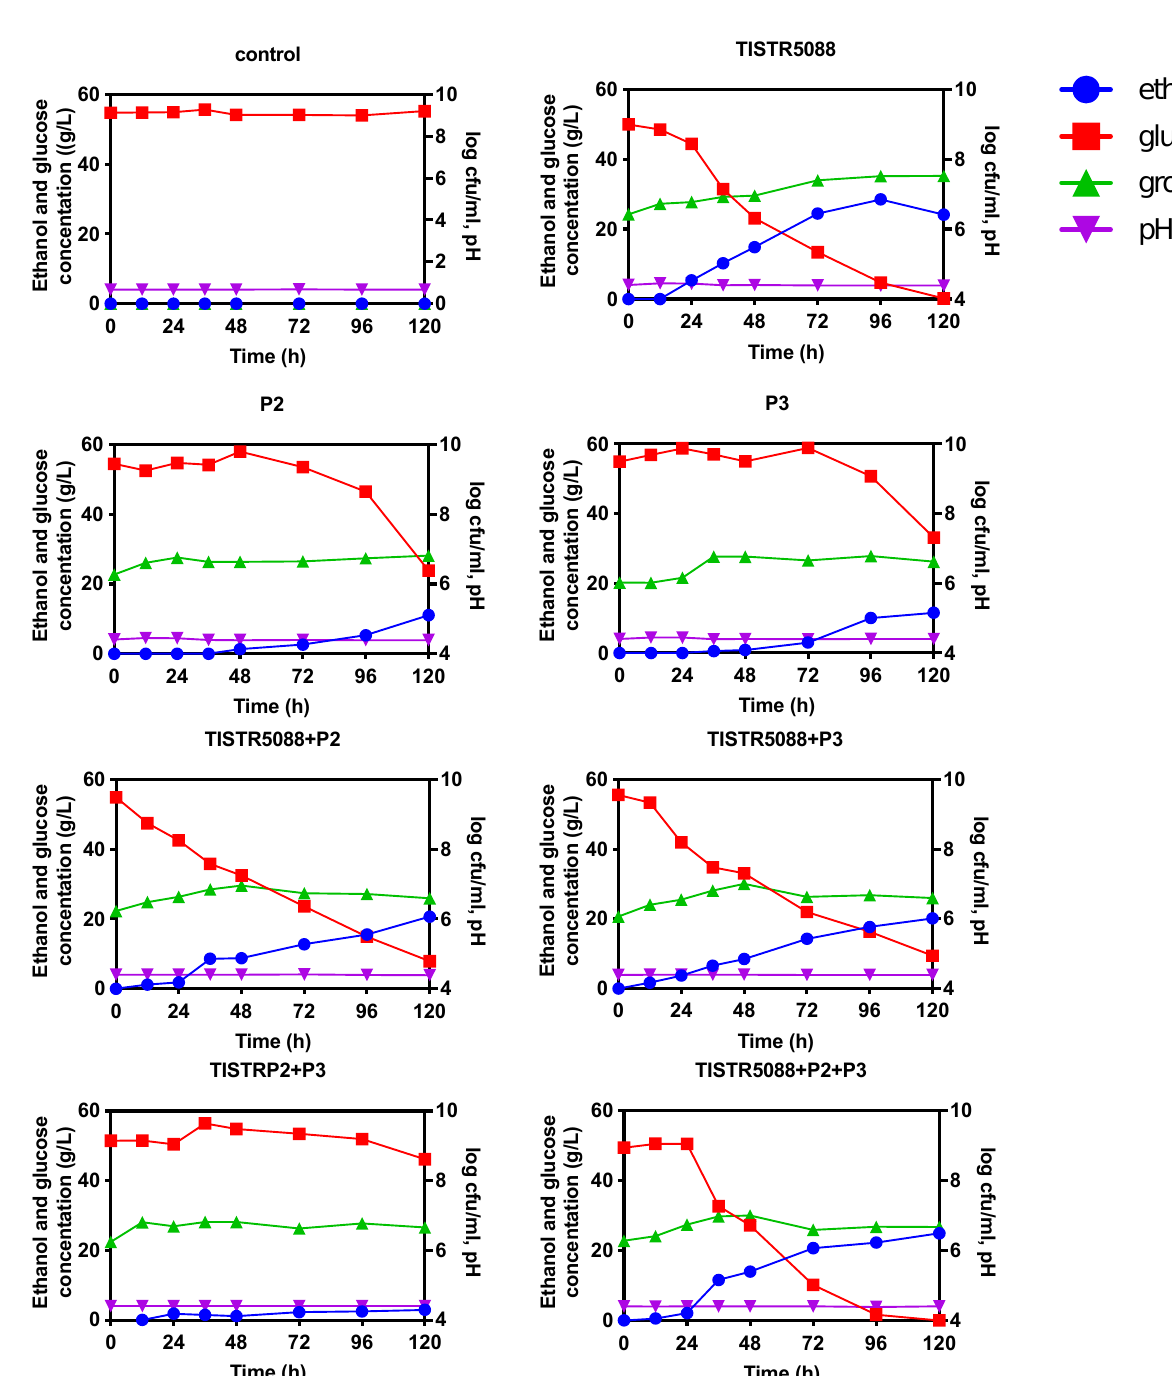
Figure 5. Cell growth, glucose, and ethanol concentration profiles during the fermentation of MF- broth fermented by S. cerevisiae TISTR 5088, W. anomalus P2 and C. rhodanensis P3, with single and co-fermentation at 30 °C for 120 h.